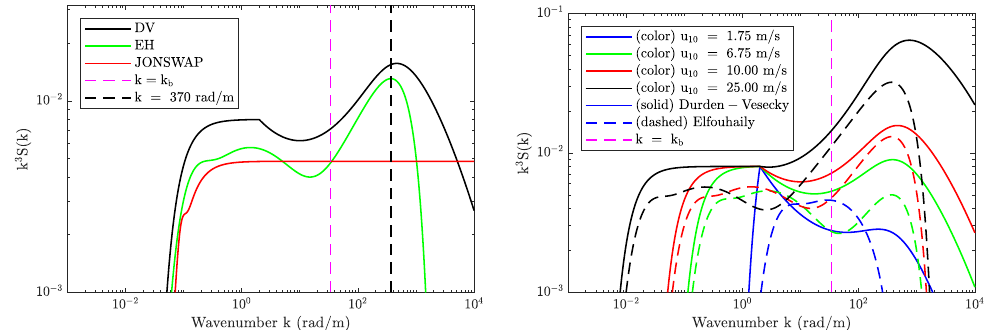
Figure 3. Comparison of wind-driven curvature spectra. ( Left panel ) compares Durden–Vesecky (DV), Elfouhaily (EH), and JONSWAP spectra at u 10 = 10 m/s. ( Right panel ) compares Durden– Vesecky and Elfouhaily curvature spectra over different wind speeds. SMAP Bragg wavenumber k b = 33.93 rad/m is also shown using a magenta dashed line in both figures. The right panel in Figure 3 compares the DV (solid curves) and EH (dashed